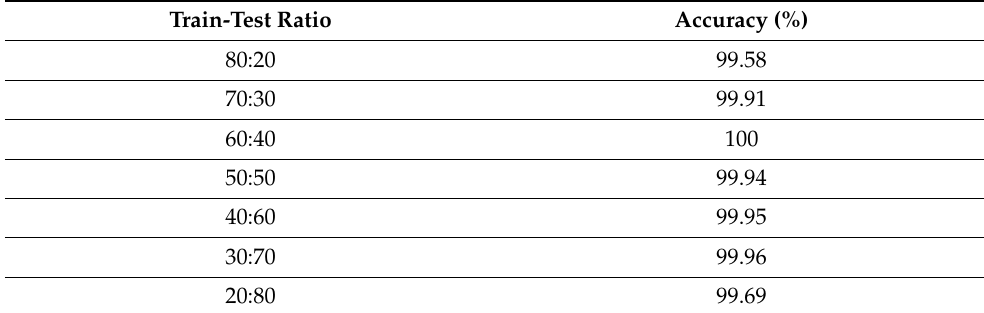
Table 6. Accuracy value for different train-test ratio.